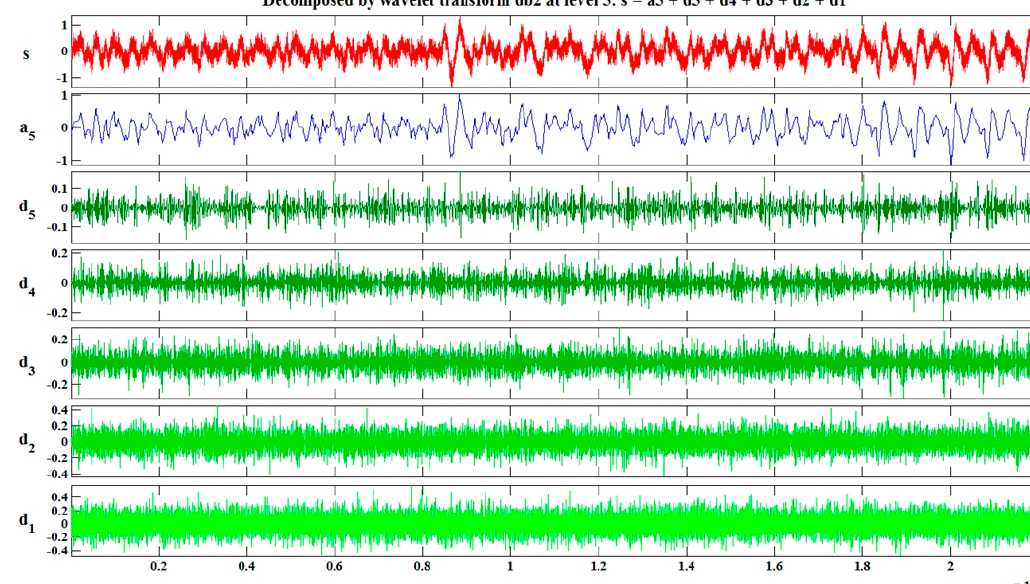
Figure 7. Gauss white noise ‐ added signal and its wavelet coefficients (SNR = 5 dB).